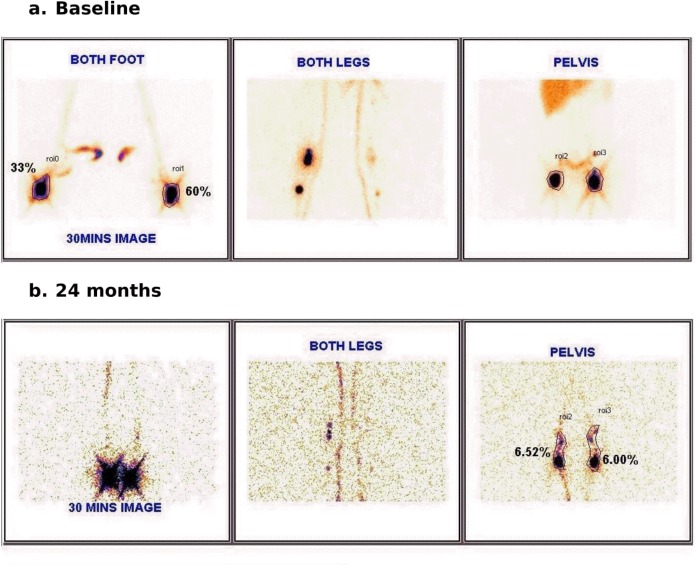
a & b: Baseline and 24 month images showing disappearance of tracer retention in popliteal lymph nodes. Lymphatic flow in both legs is improved (a) baseline. (b) 24 months.